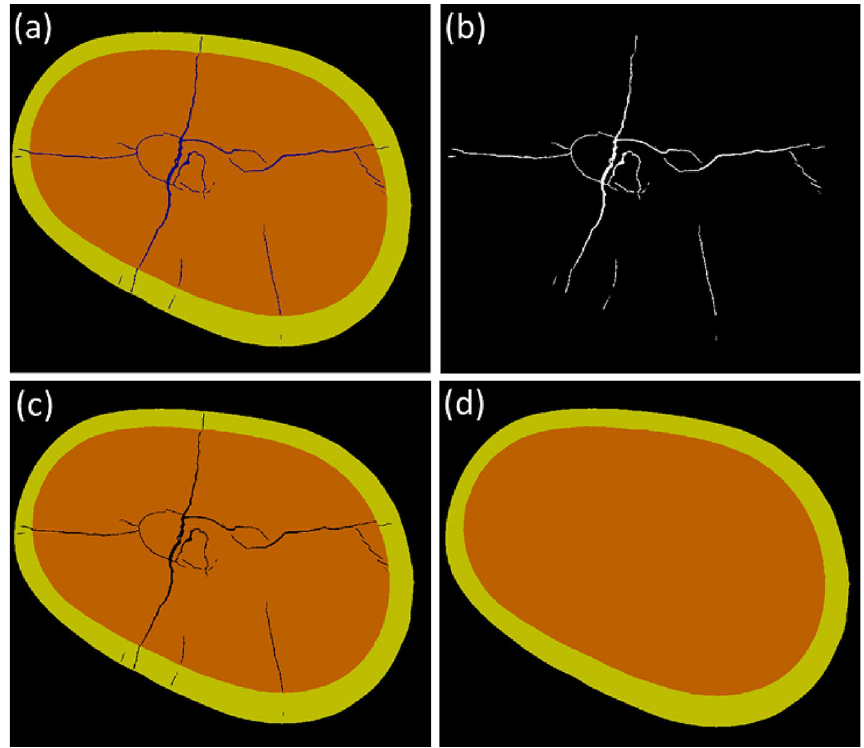
Figure 3. Example of X-ray µ CT data-cube slice-by-slice segmentation with convolutional neural network (CNN) to produce data-cubes of structural elements of a tooth. ( a ) CNN’s predictions on slice image with enamel (yellow), dentin (brown), cracks (dark blue), and air (black) indicated. ( b ) Binary mask of cracks, which was used to fill in the segmentation image shown in ( c ), resulting in isolated areas of enamel and dentin presented in ( d ) as if there were no cracks in the tooth. One pixel corresponds to (https:// numpy. org) was used to process data-cubes, which were visualized with “Matplotlib 3.6.0” 50 (https:// matpl otlib.